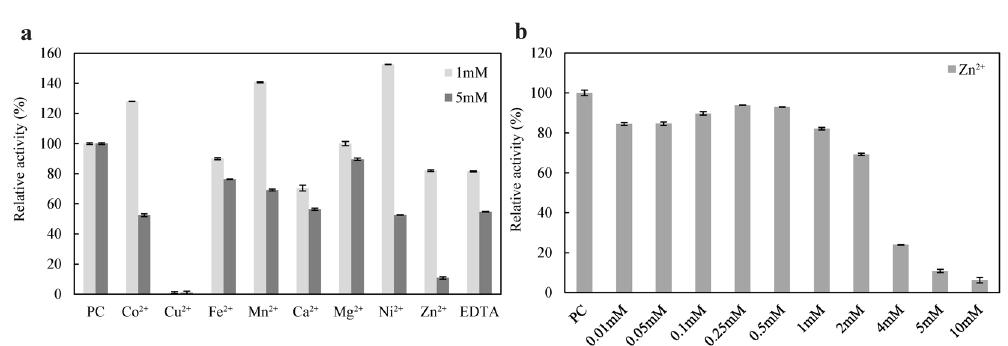
Figure 4. ( a ) Effect of metal ions and EDTA on AiiK activity. ( b ) Effect of zinc on AiiK activity in vitro . All experiments were carried out in triplicates. (PC stands for positive control, containing 4 μ g/mL AiiK, 50 μ M C 10 - HSL, and 10 mM PBS (pH 7.4), then the reaction was performed at 45 °C for 10